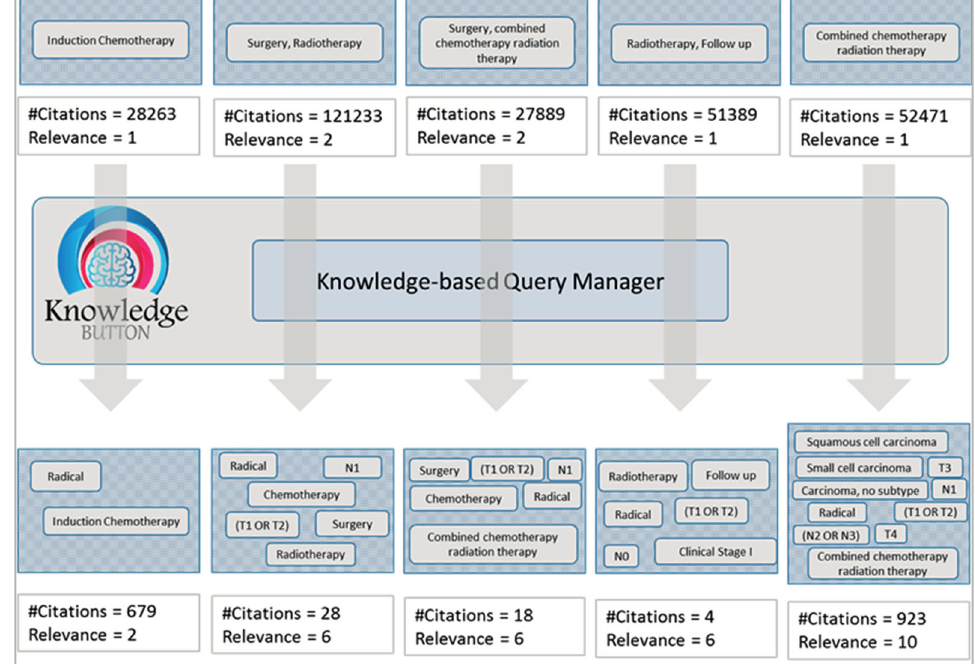
Figure 7. Number of citations is reduced with increased relevance using a knowledge-based query construction